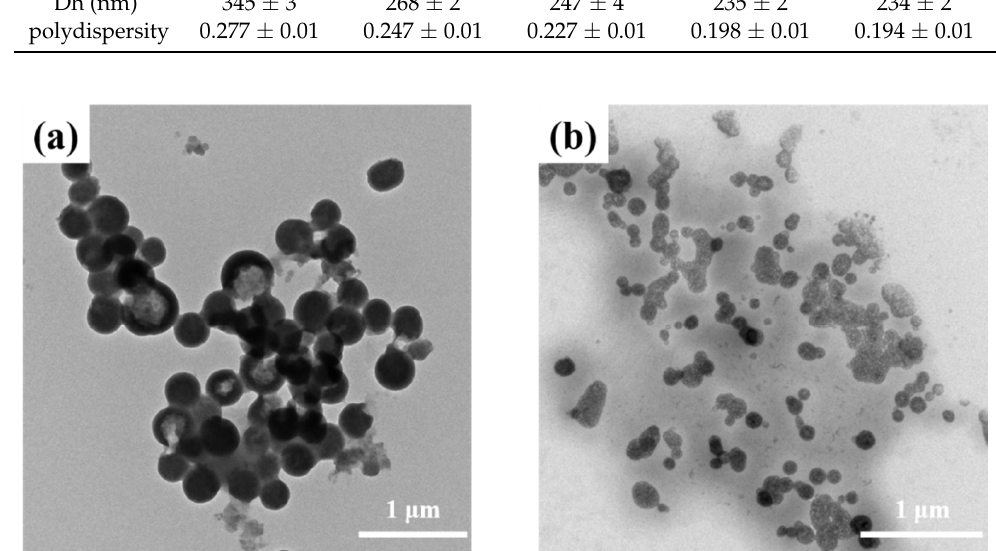
Figure 7. TEM images of ( a ) PNI-C 60 micelles and ( b ) PNI-C 60 micelles after heating.